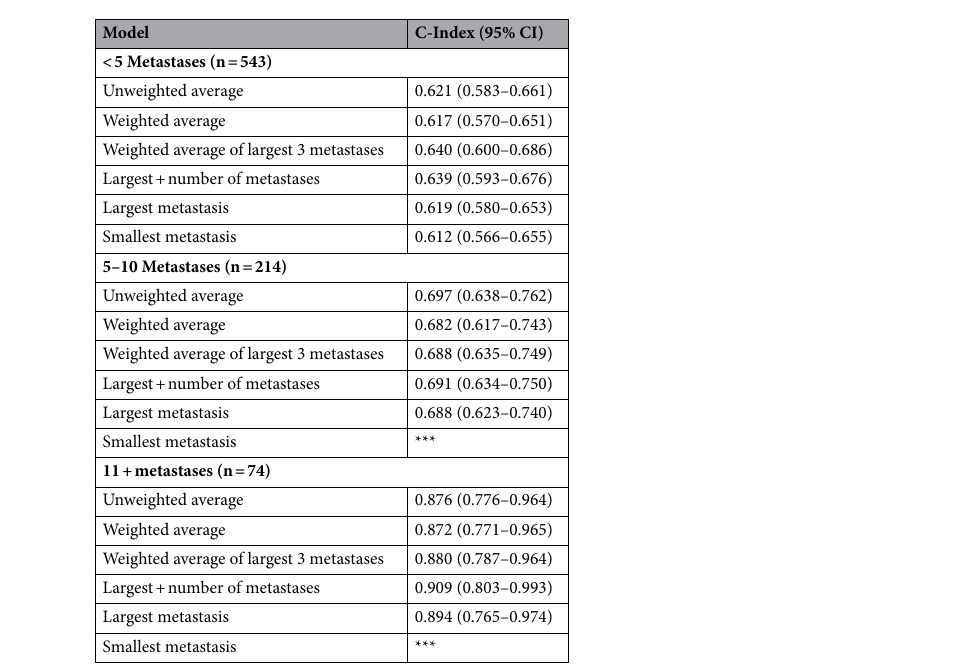
Table 3. Sub-Analysis: Number of Metastases. ***